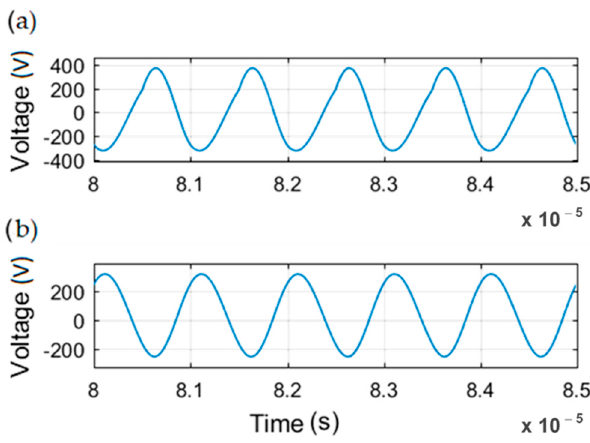
Figure 13. Waveforms of ( a ) voltage drop on inductor U L and ( b ) voltage drop on capacitor U Cg .